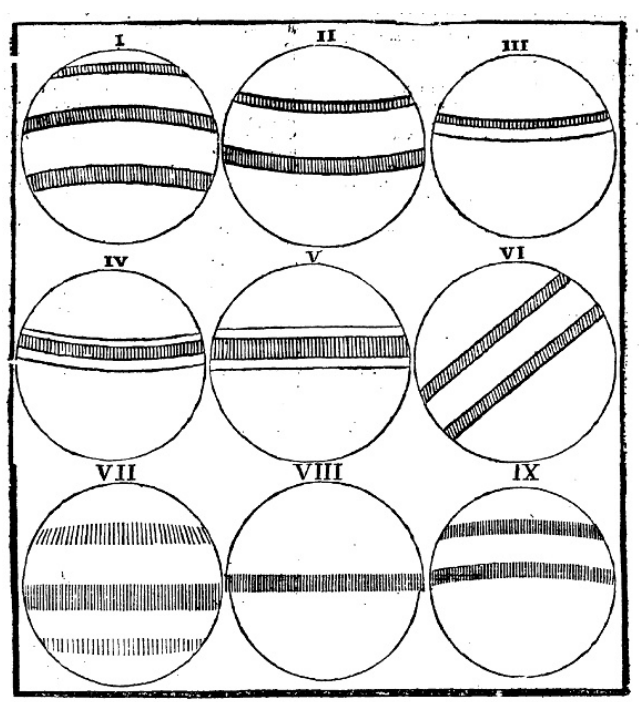
Fig. 3. Figures from Riccioli’s Astronomia Reformata used to illustrate the appear- ance of Jupiter. Some of the (cid:12)gures represent a speci(cid:12)c observation. Others simply represent a general appearance that is referenced for multiple